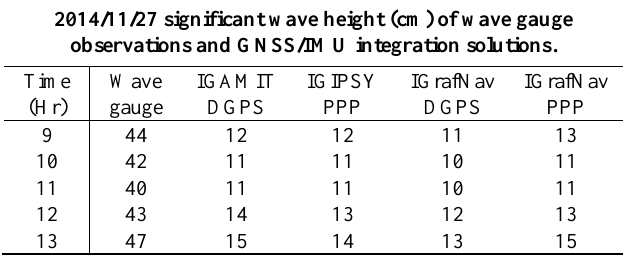
Table 4. Significant wave height of Anping wave gauge observations and integration solutions on November 27, 2014. 2014/11/27 significant wave height (cm) of wave gauge observations and GNSS/IMU integration solutions.